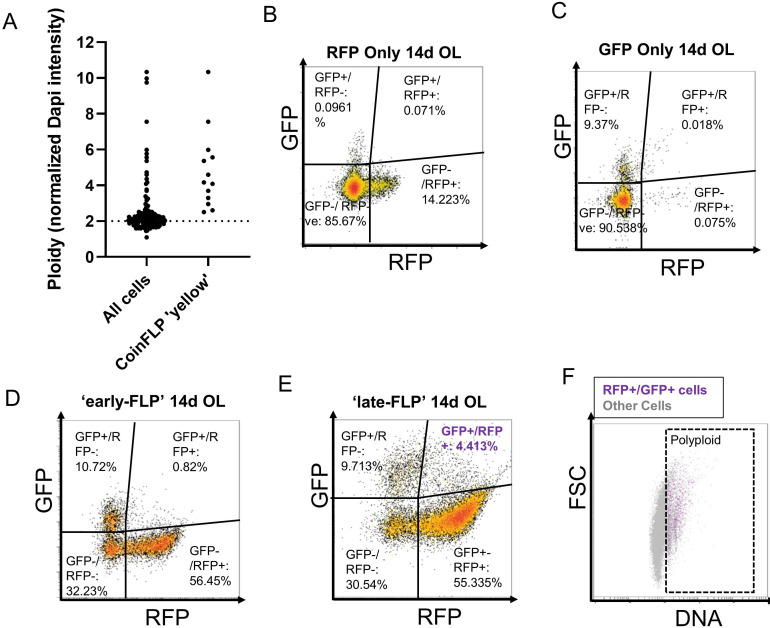
CoinFLP ‘double-labeled’ cells have polyploid DNA content.(A) DAPI integrated intensity was quantified for 132 nuclei from CoinFLP- labeled 14 day optic lobes using FIJI. Nuclear boundaries were guided by lamin staining for Dapi quantifications from at least 10 randomly chosen cells from 11 different representative images, from eight different brains. CoinFLP double-labeled cells are polyploid. (B,C) Single color controls used for gating. (B) shows RFP only and (C) shows GFP only controls. (D) CoinFLP animals were heat shocked at day of eclosion to induce labeling and brains were harvested at 14 days post eclosion. Inducing labeling at day one shows very few (0.82%) of cells in the OL that are double labeled. (E) CoinFLP labeling was performed 24 hr before harvesting. 4.413% of the OL are double labeled. (F) DNA content dot plot showing all cells in the brain in grey and the double labeled cells from (E) in purple. 97% of double labeled (GFP+/RFP+) cells from ‘late-FLP’ OL show polyploid DNA content. Single color controls in (B) and (C) are siblings from the cross y,w,hsflp;lexAop-nlsRFP/Cyo;UAS-nlsGFP/TM6B x y,w; CoinFLP. ‘RFP only’ and ‘GFP only’ are progeny that respectively, did not inherit the UAS-GFPnls and LexAop-RFPnls. cassettes and therefore contain balancer chromosomes. These controls were only used for gating purposes and not to estimate the efficiency of labeling.Figure 4—figure supplement 2—source data 1.Source Data for Figure 4—figure supplement 2 panel A.